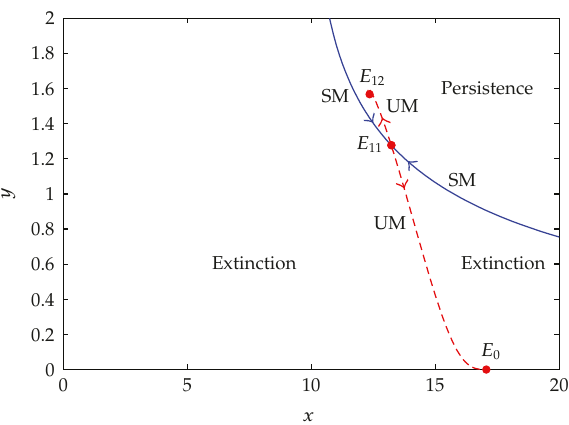
Figure 2: Illustrations of the Allee e ff ect for (cid:2) 1.5 (cid:3) . Here, λ (cid:7) 17 . 06 , d (cid:7) 1 . 0 , a (cid:7) 3 . 0 , ID 50 (cid:7) 2. E 0 (cid:7) (cid:2) 17 . 06 , 0 (cid:3) is stable, E 11 (cid:7) (cid:2) 13 . 2311 , 1 . 2763 (cid:3) is a saddle point, E 12 (cid:7) (cid:2) 12 . 3589 , 1 . 567 (cid:3) is stable. Note that SM is the stable manifolds of E 11 (cid:2) solid line (cid:3) , UM is the unstable manifolds of E 11 (cid:2) dash line (cid:3) , and the phase portrait of